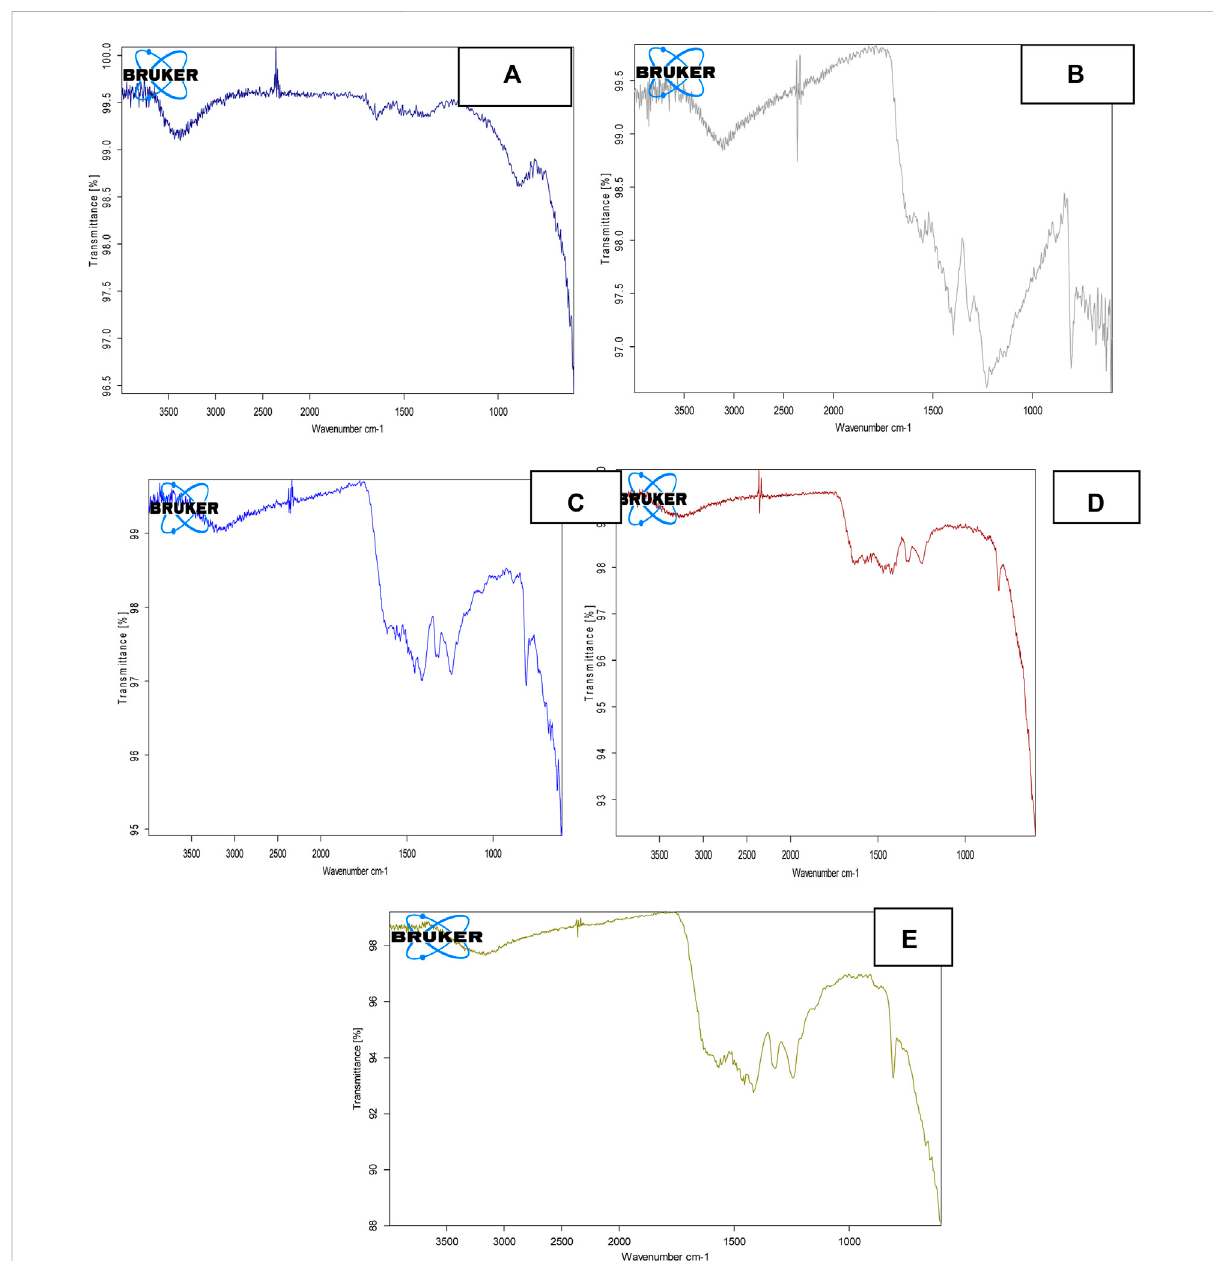
FIGURE 3 FT-IR spectra of (A) ZnFe 2 O 4 NPs (B) S-g-C 3 N 4 (C) 10% ZnFe2O4/S-g-C3N4 NC, (D) 30% ZnFe2O4/S-g-C3N4 NC, (E) 50% ZnFe2O4/ S-g-C3N4